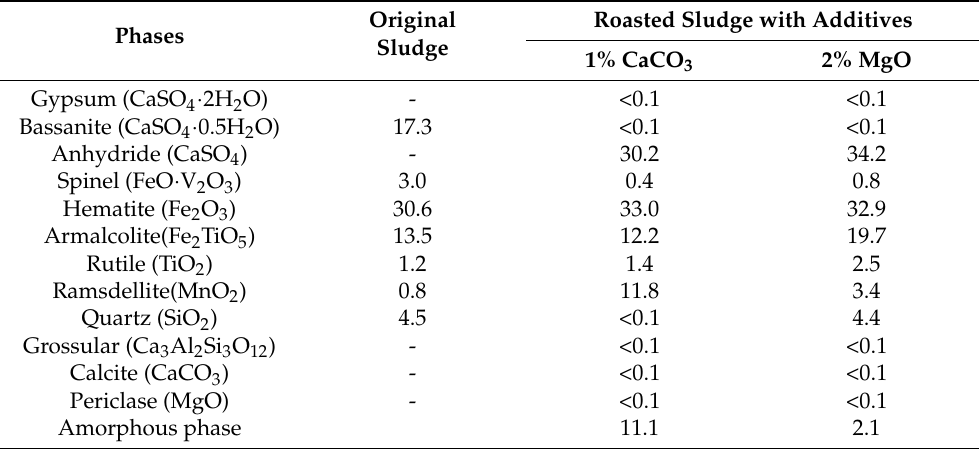
Table 4. The quantitative phase composition of original [37] and roasted vanadium sludges, wt.%.